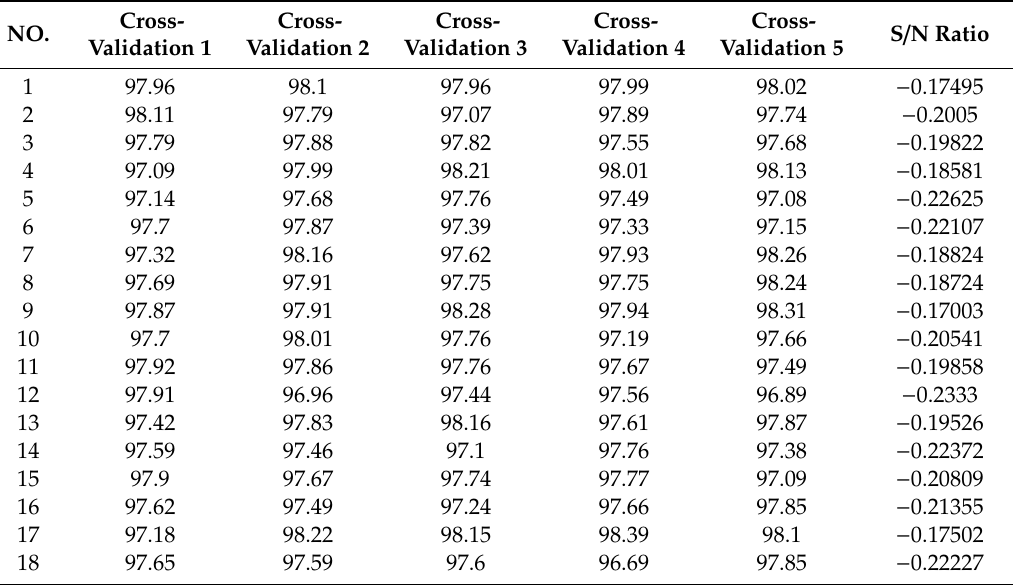
Table 8. Accuracy and S / N ratio of AlexNet in MORPH database.